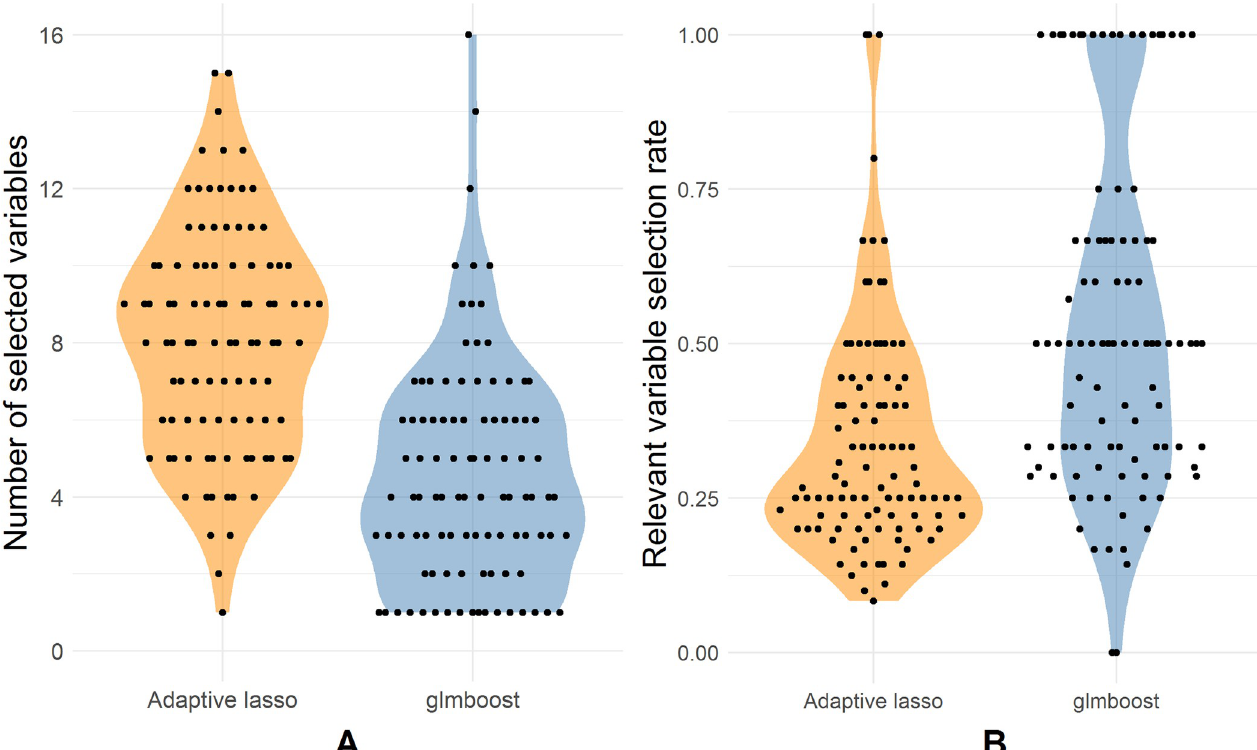
Fig 2. Summary of numbers of selected variables and selection rates of relevant variables. ( A) Numbers of selected variables per simulation in 100 realizations. (B) selection rates of relevant variables per simulation in 100 realizations.